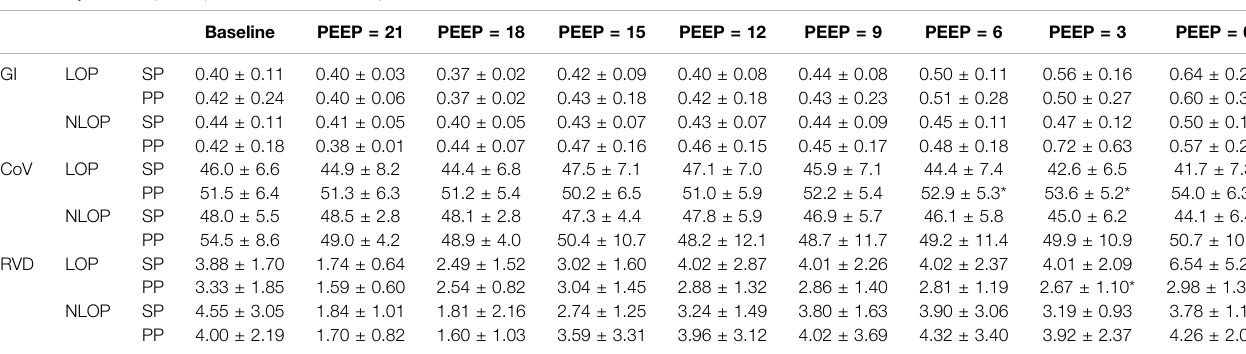
PEEP, positive end-expiratory pressure; GI, global inhomogeneity index; CoV, center of ventilation; RVD, regional ventilation delay; * p < 0.05 compared with supine position.